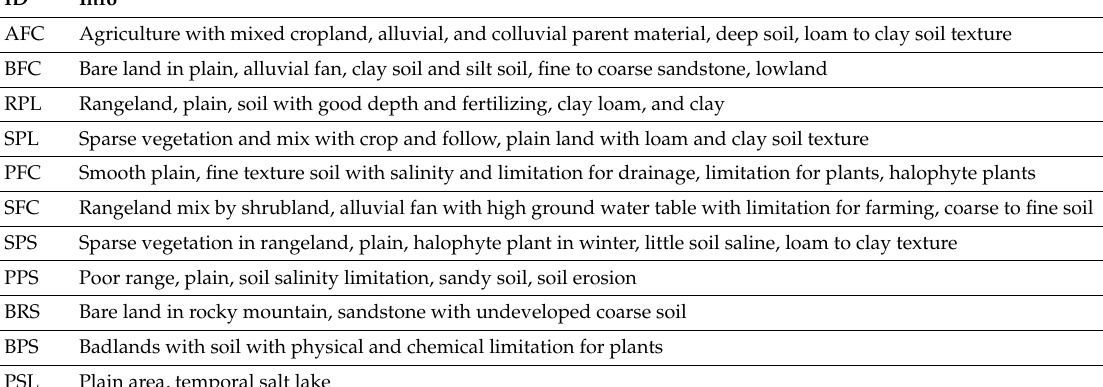
Table 3. Unit code descriptions of the land unit area map (Figure